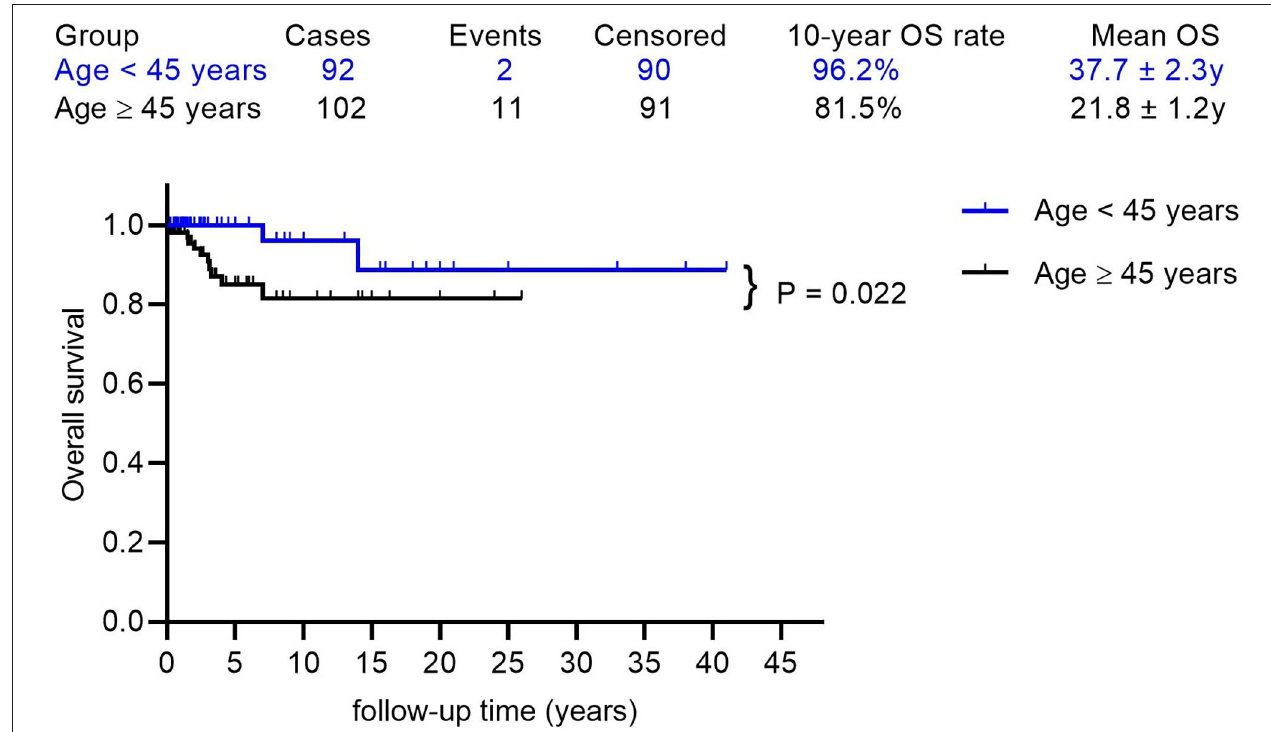
FIGURE 3 | The Kaplan-Meier (log-rank) test showed a significantly different OS rate between patients with ages < 45 years and ages ≥ 45 years ( p = 0.022).